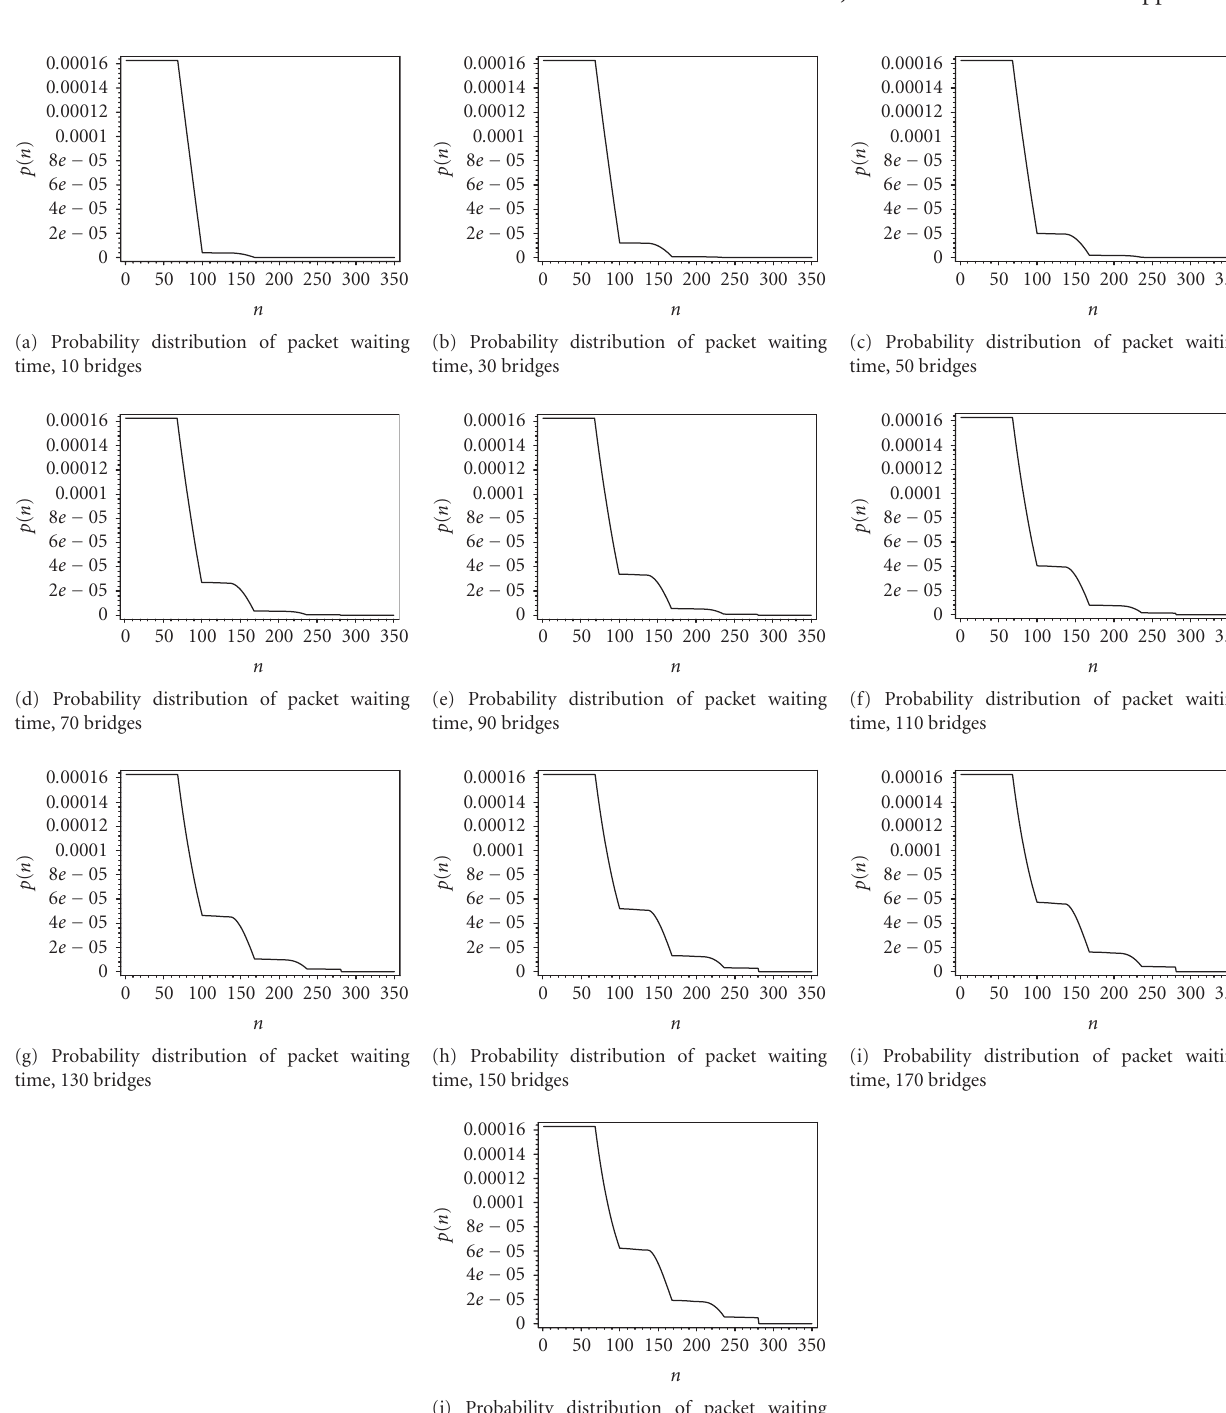
the number and intensity of higher-order backo ff attempts increases and higher-order peaks become more